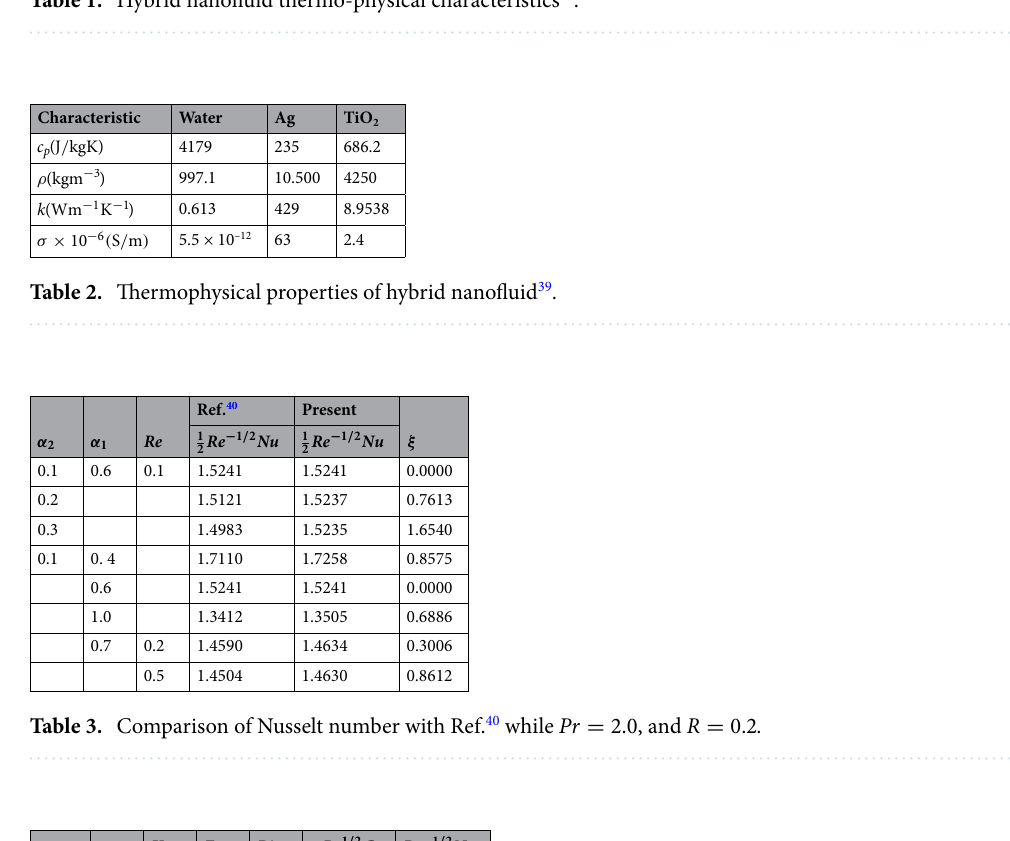
Table 1. Hybrid nanofluid thermo-physical characteristics 38 .